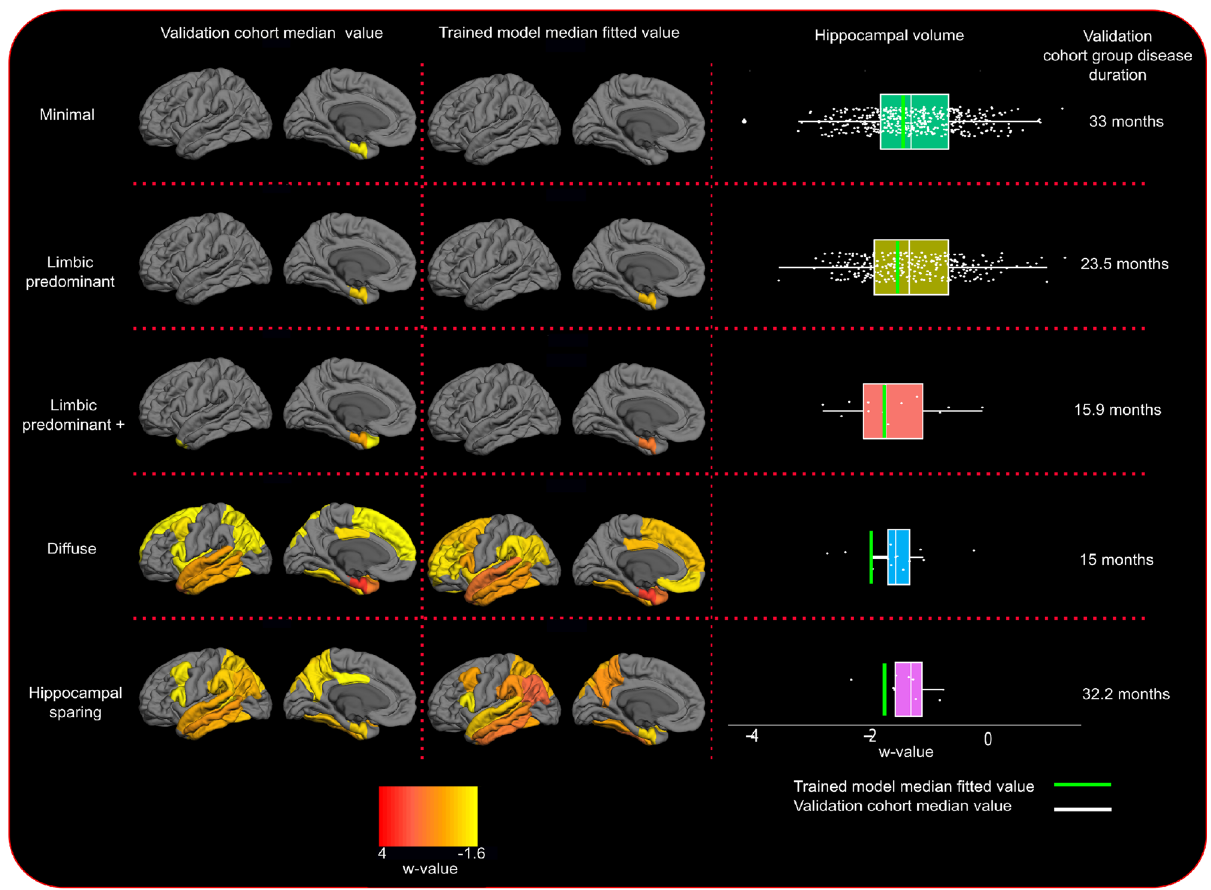
Fig. 6 | Comparison of model- fi tted values and validation dataset atrophy levels. Atrophy- fi tted values after the AD onset for the trained clustering model versusthenewvalidationdataset.Newobservationswereclassi fi edtoeachcluster, and median disease duration was calculated. Then atrophy- fi tted values at the median disease duration of each cluster were calculated through the clustering model(middlecolumn).Medianatrophymaps(groupmedianatrophy)forthenew data of each cluster are presented in the left column. The right column shows the hippocampal volumes of each cluster ’ s (boxplot colors: green; minimal; n =420, olive; limbic predominant; n =283, orange; limbic predominant+; n =12, blue;